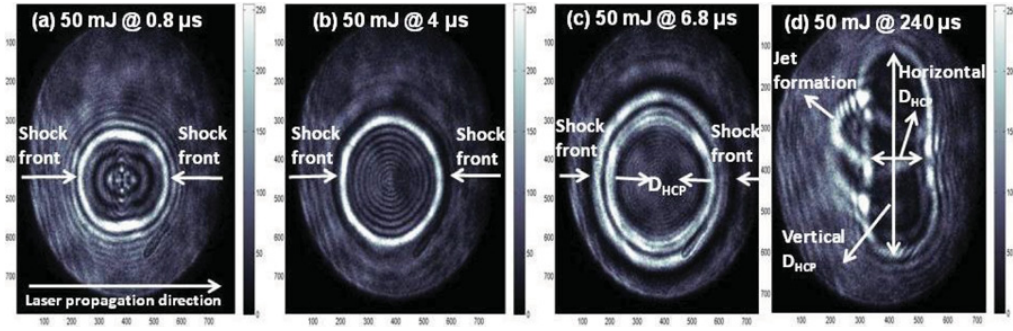
Figure 2. : Shadowgram showing SW and CB at (a) 0.8 (cid:1) s (b) 4 (cid:1) s (c) 6.8 (cid:1) s and (d) 240 (cid:1) s for